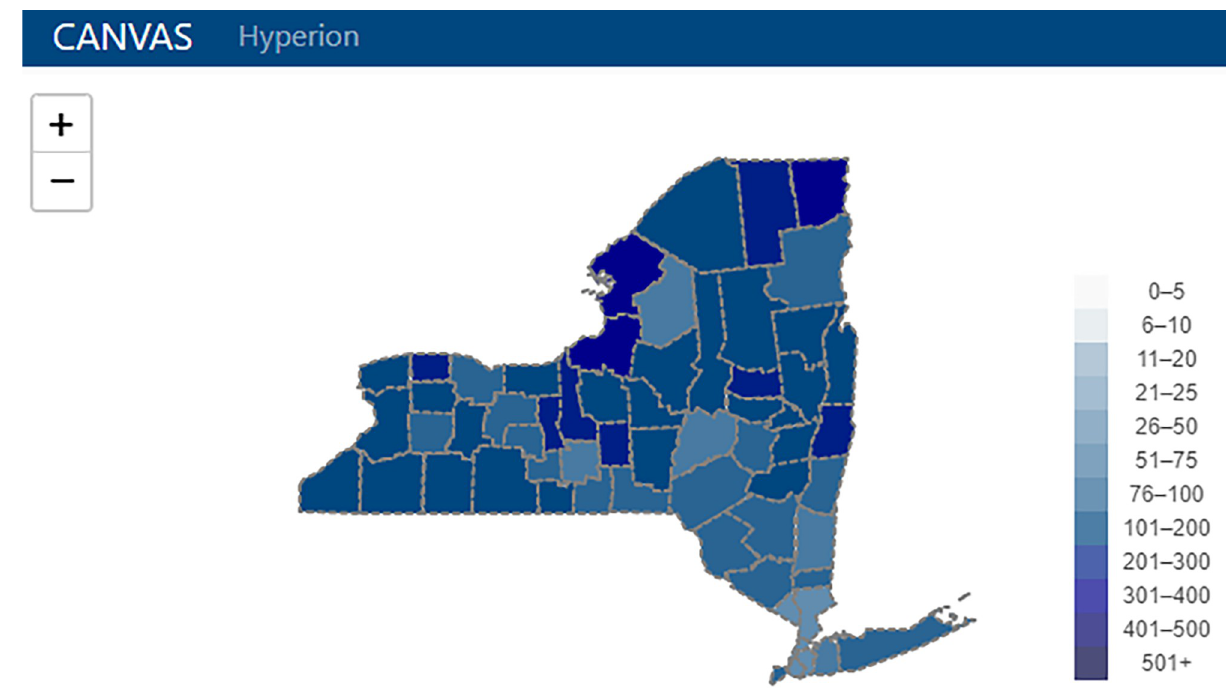
Fig 3. CANcer Visual Analytic System (CANVAS) visual. Map created using Leaflet with data from OpenStreetMap